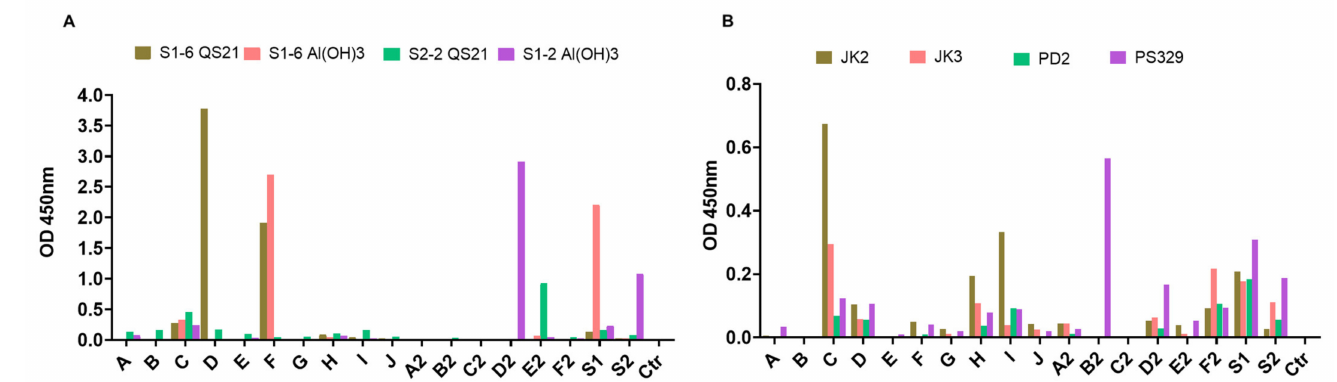
Figure 3. Epitope mapping results of vaccinated mouse plasma ( A ) versus human recovered plasma ( B ). Coating peptides A–J are peptides from the S1 protein, A2–F2 are peptides from the S2 protein. S1 is the recombinant S1 of the S protein and S2 is the recombinant S2 of the S protein. Ctr is a control peptide of human alpha-synuclein protein, which served as a negative control. Plasma was diluted at a 1:800 dilution with the sample, and ELISA results were shown in the graphs.